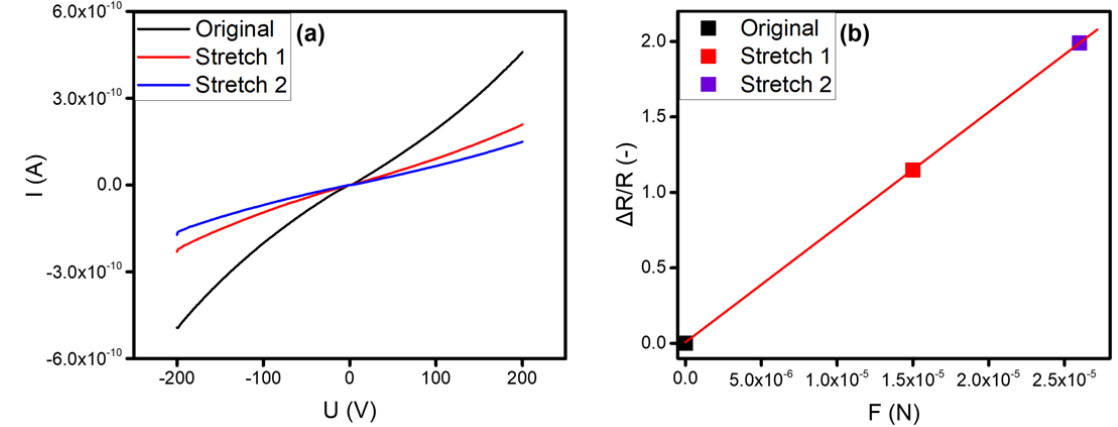
Figure 3. ( a ) Current versus voltage (I-U curves) of SiC nanowire for conductivity in different stretching states. ( b ) The relationship between relative resistance change ( ∆ R/R ) of SiC nanowire and tensile force ( F